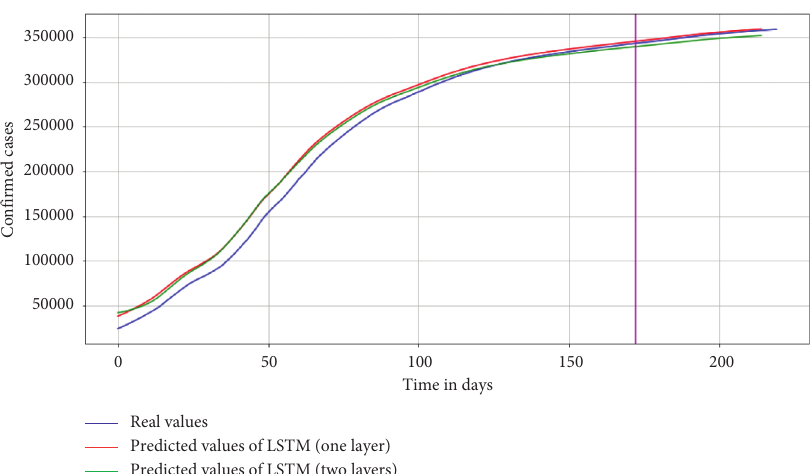
Figure 6: Comparison between real confirmed cases and the predicted confirmed cases for LSTM (Saudi Arabia).